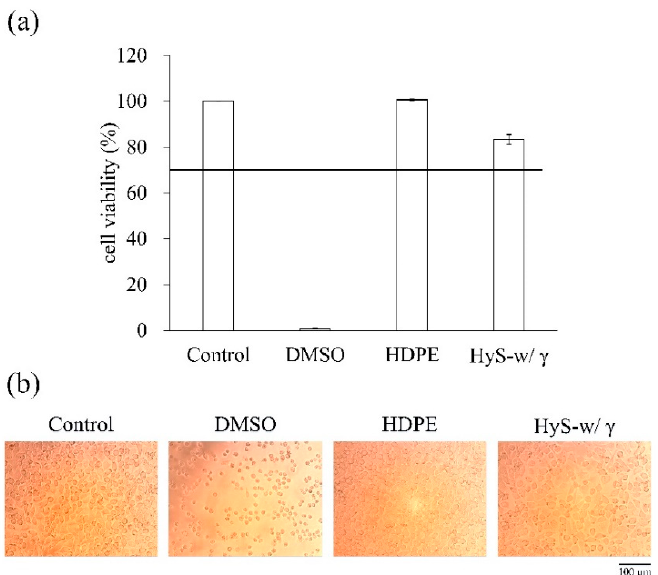
Figure A2. ( a ) Quantitative and ( b ) qualitative ( n = 6) cytotoxicity test results of hydrogel macrosphere extract cultured with L929 cells for 24 h.